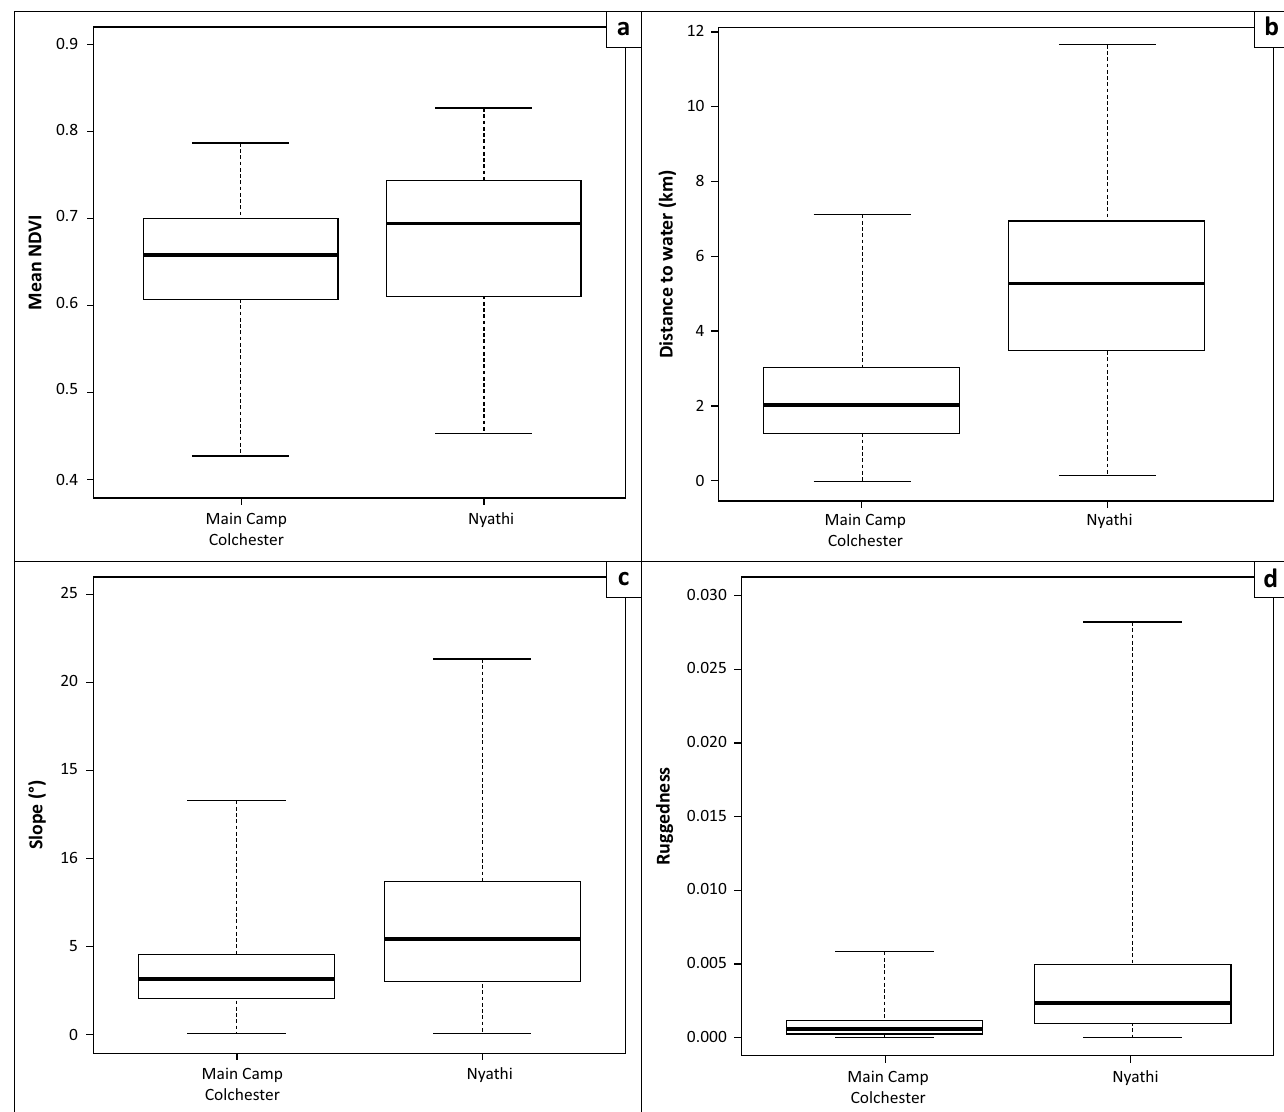
Box plots depict the median value (thick horizontal line), upper and lower quantiles (box boundary) and range (whiskers). The Normalised Difference Vegetation Index box plot and Wilcoxon rank- sum test were based on the mean Normalised Difference Vegetation Index values depicted in Figure 2-A1 rather than on the time-specific Normalised Difference Vegetation Index layers used in the step selection function models. Note that the y -axes differ between plots. FIGURE 3-A1: Covariate values differed between the Main Camp – Colchester and Nyathi sections for (a) Normalised Difference Vegetation Index (Wilcoxon rank-sum test W = 3 517 400, p < 0.001), (b) distance to artificial water ( W = 1 270 300, p < 0.001), (c) slope ( W = 2 636 900, p < 0.001) and (d) terrain ruggedness ( W = 1 871 300, p <